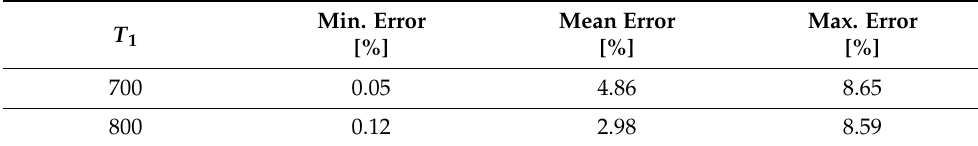
Table 3. Relative error of estimated relaxation